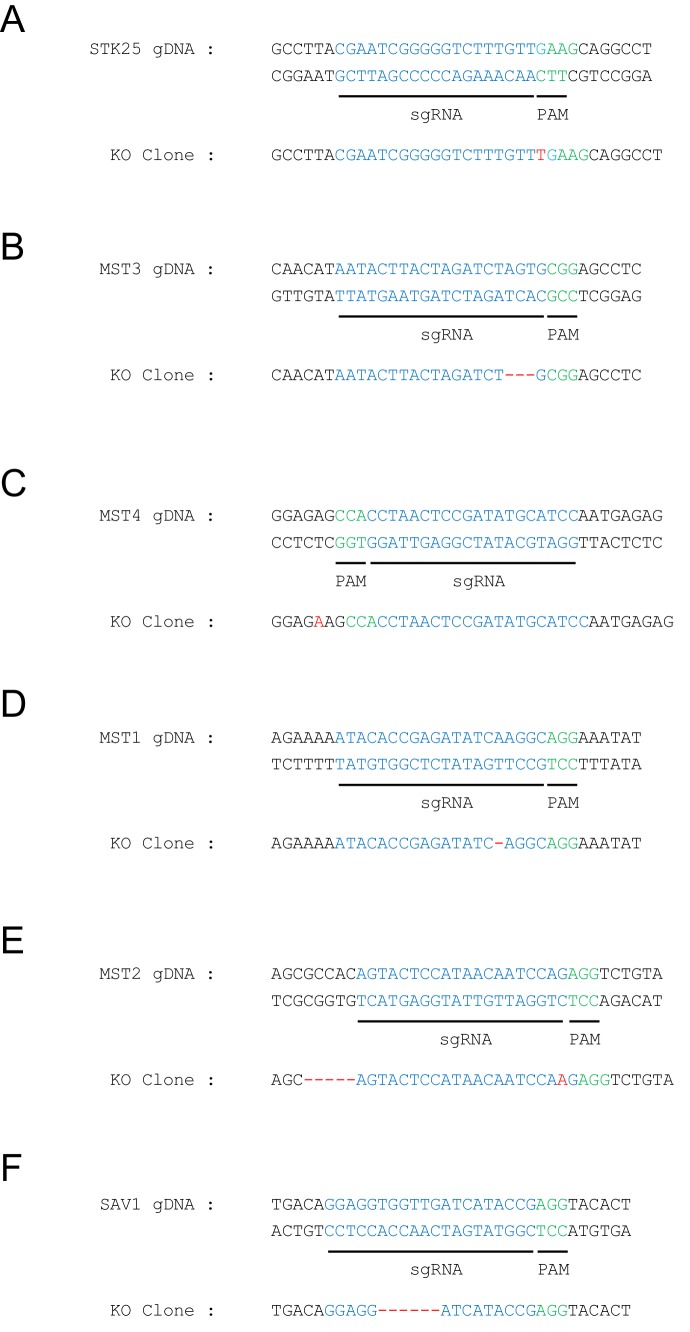
CRISPR/Cas9-induced indel mutations in 293A cells.(A to F) Intact genomic sequences of STK25, MST3, MST4, MST1, MST2, and SAV1 are shown in the top panels. The indel mutations in corresponding KO cell lines are shown in the bottom panels.